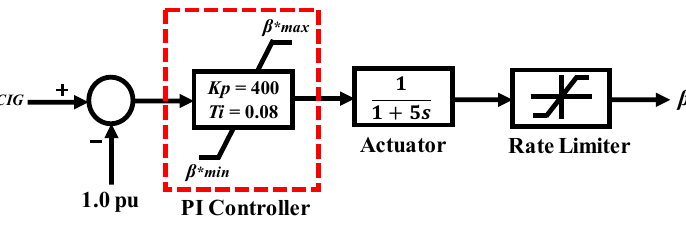
Figure 2. Pitch controller for fixed ‐ speed wind turbine (FSWT).